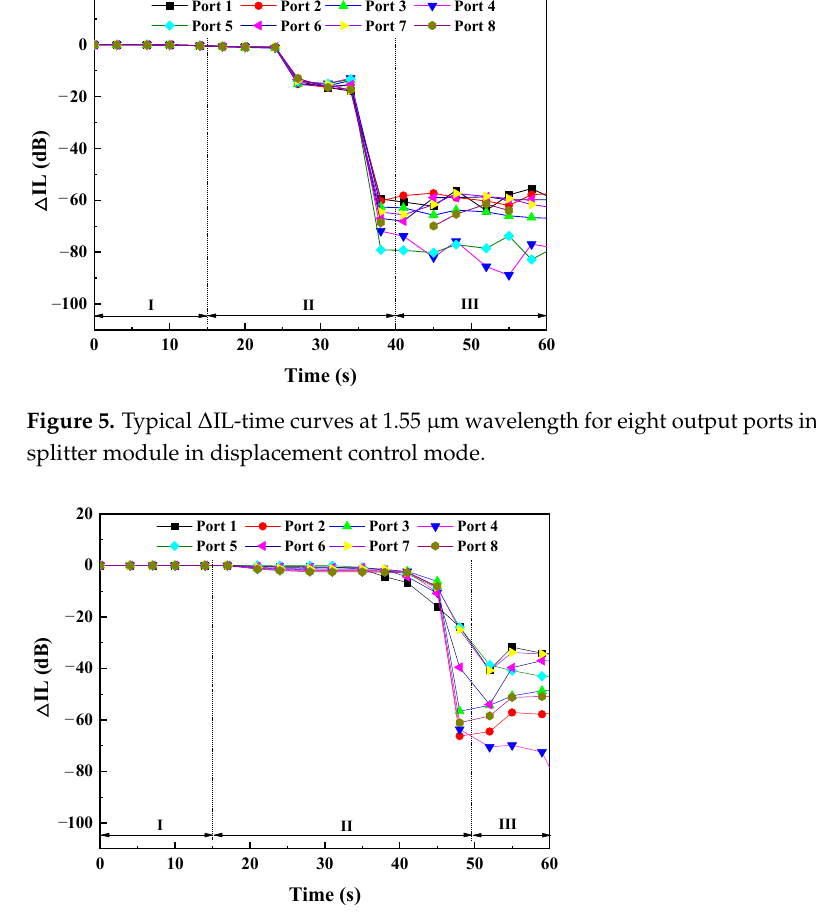
Figure 6. Typical ∆ IL-time curves at 1.55 µ m wavelength for eight output ports in a 1 × 8 PLC optical splitter module in load control mode.